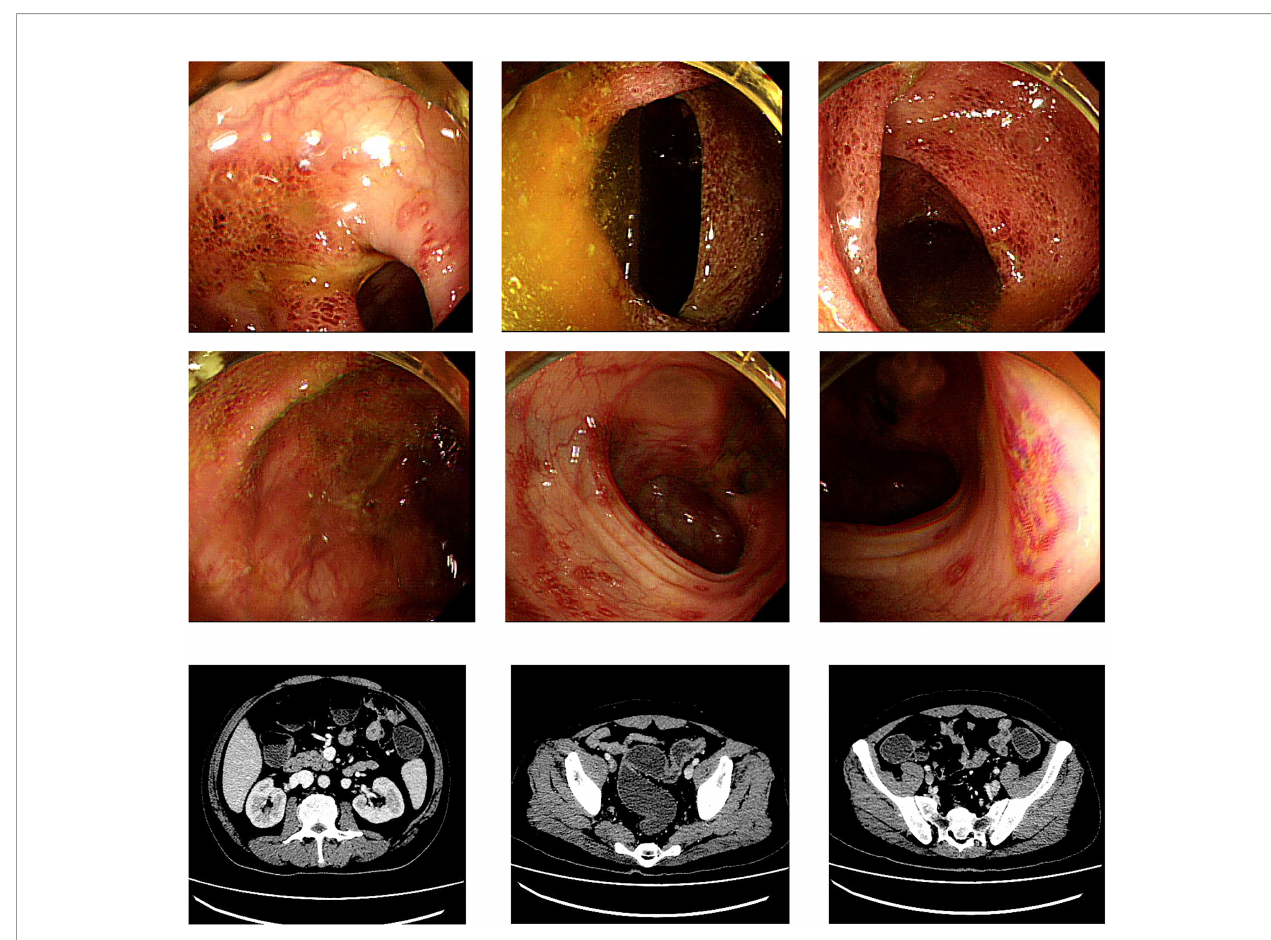
FIGURE 1 | Colonoscopy and CT manifestations at diagnosis: Colonoscopy: extensive erythema, edema, fragility, loss of blood vessel texture, erosion and ulcers in the colorectal; CT: colorectal dilatation, effusion, visible air- fl uid